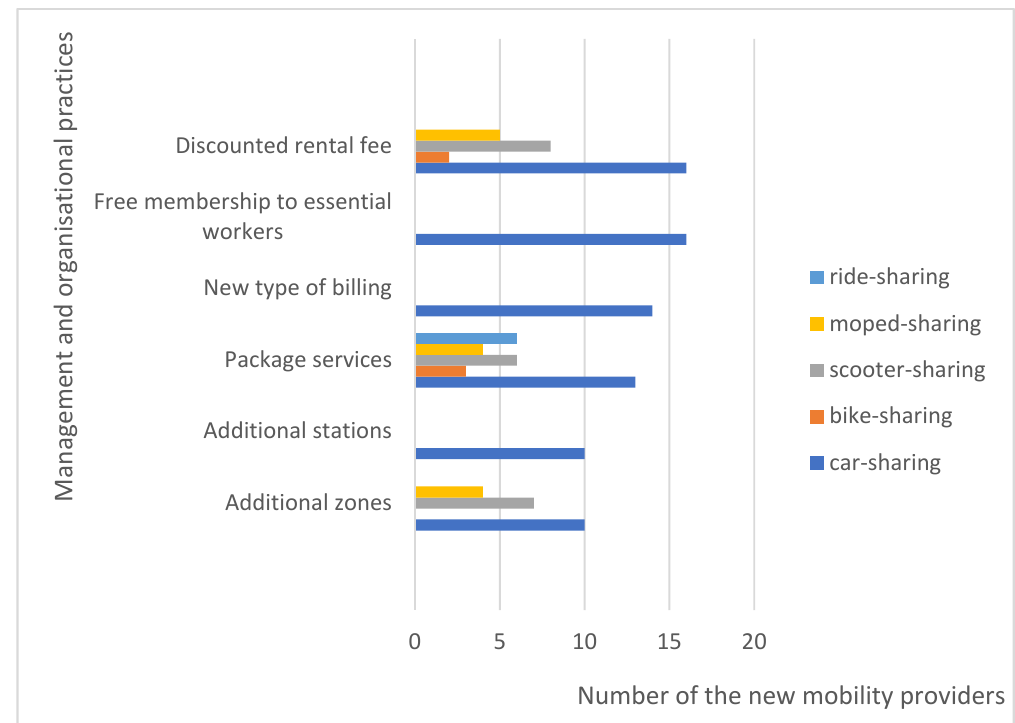
Figure 5. Management and organizational practices from the new mobility providers point of view—detailed results broken down into new mobility sectors. Table 4. Comparison of business practices in new mobility systems—safety issues.